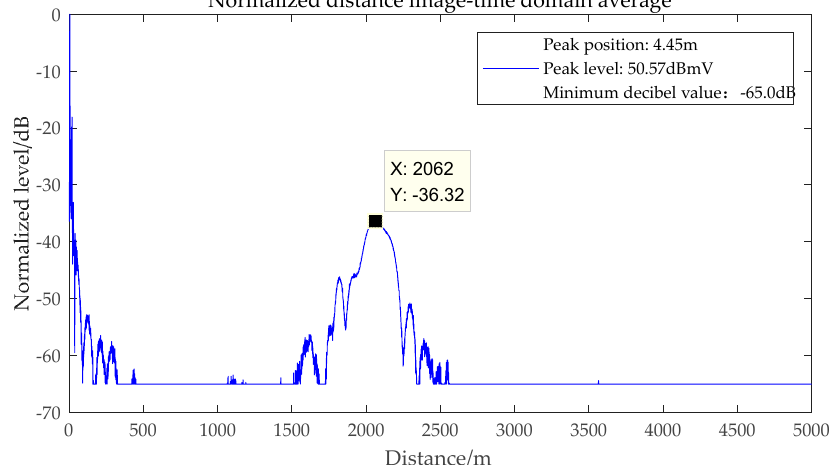
Figure 2. One-dimensional range image of single frequency electromagnetic interference false alarm signal.